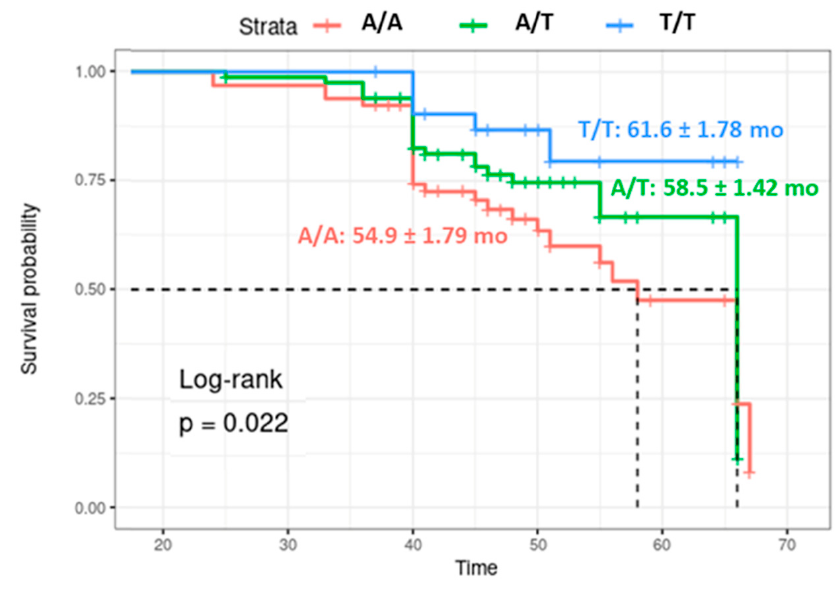
Figure 4. Kaplan–Meier survival curves for LINC-ROR genotypes. The X -axis represents the overall survival in months. The Log-Rank test was used for overall and pairwise comparison. The Bonferroni test was applied for p -value adjustment. Dashed black lines represent the median times.